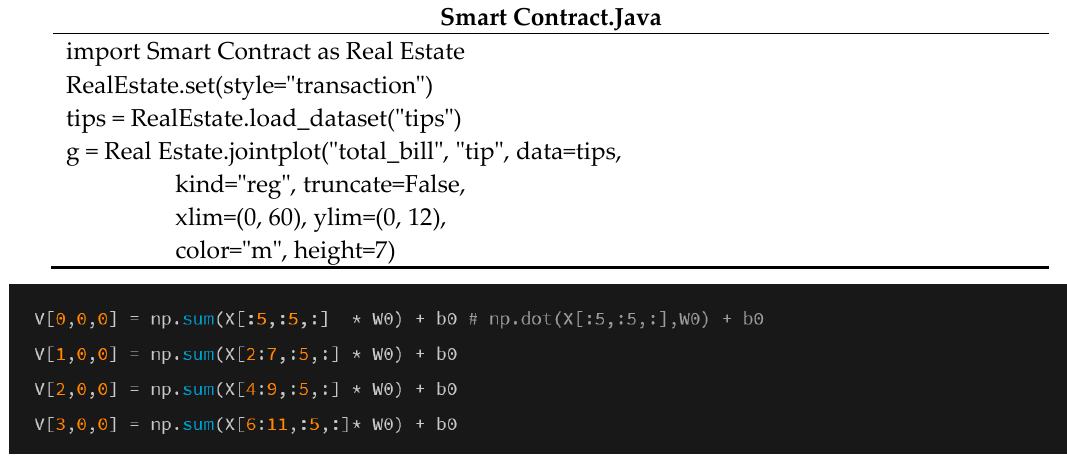
Figure 8. Smart contract source code for real estate.